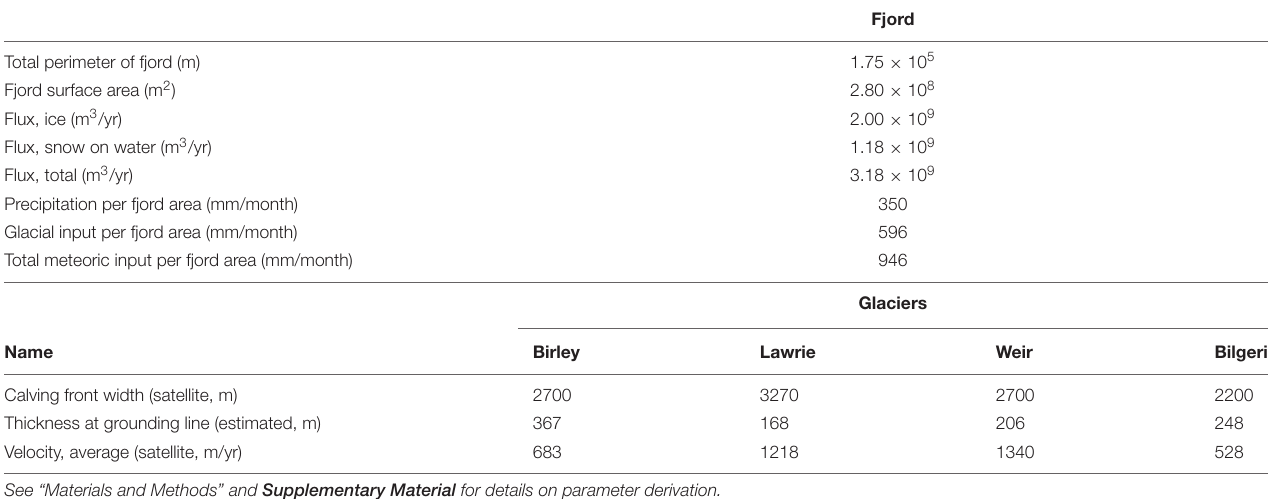
TABLE 2 | Ice flux model parameters, including inputs and outputs.